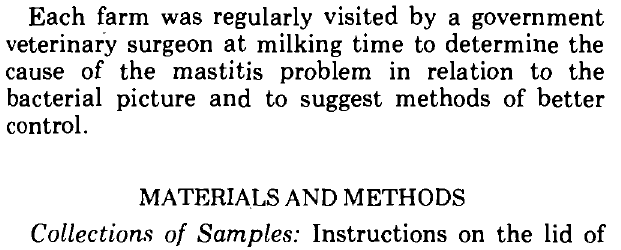
Table 1: PERCENTAGE INCIDENCE OF